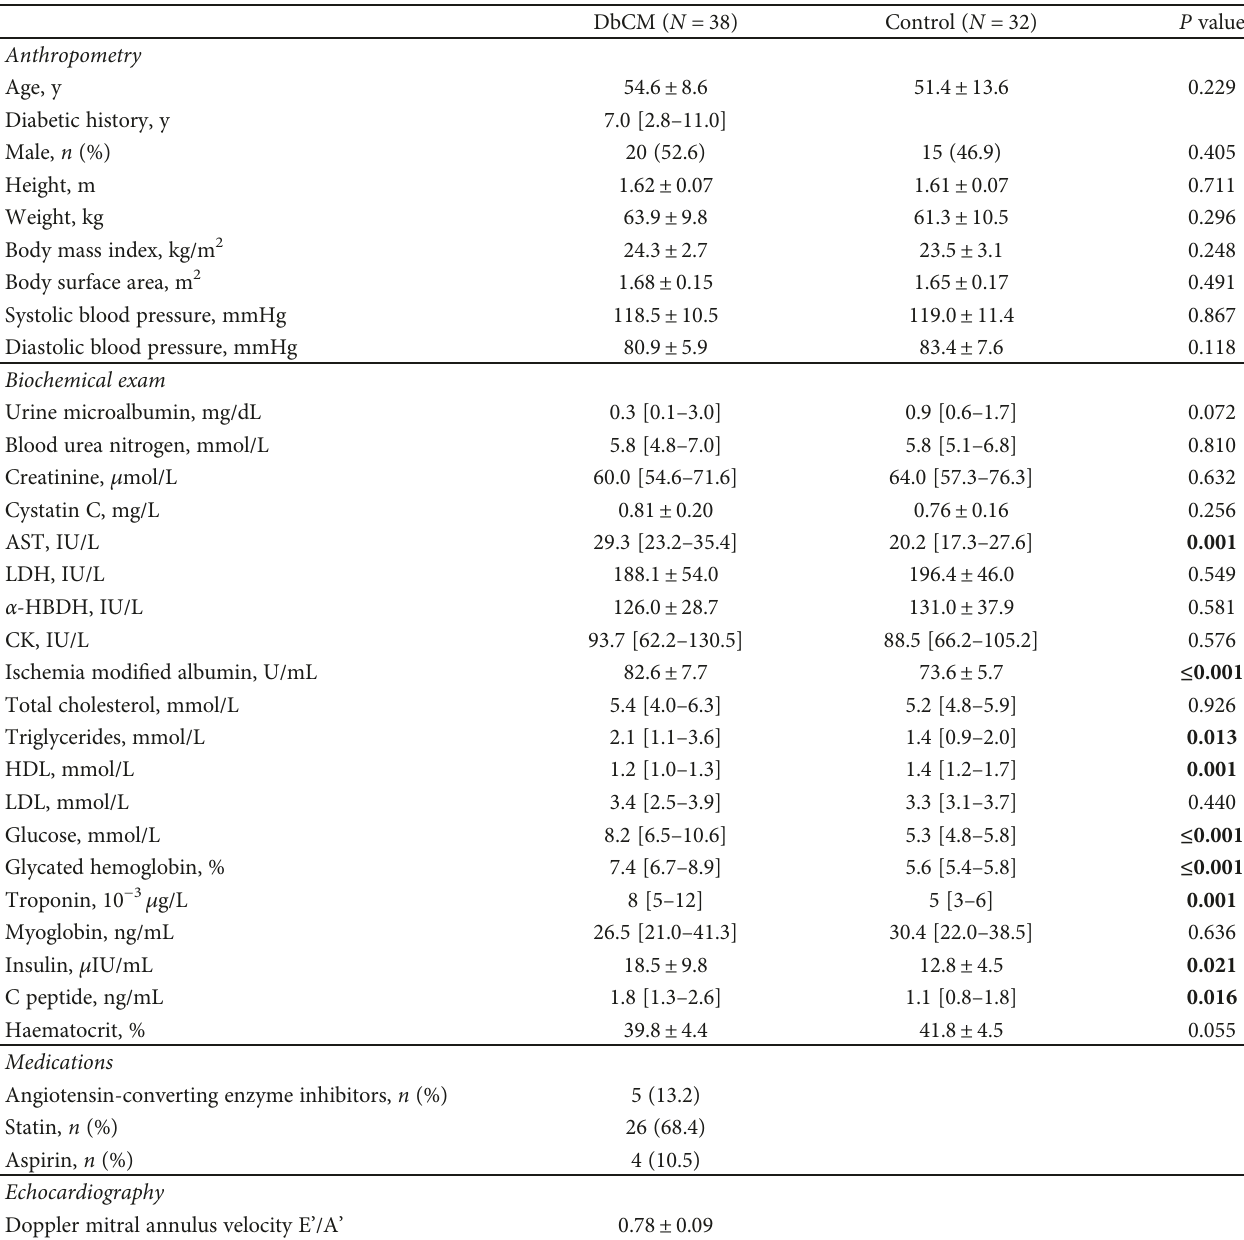
Table 1: Anthropometry and biochemical